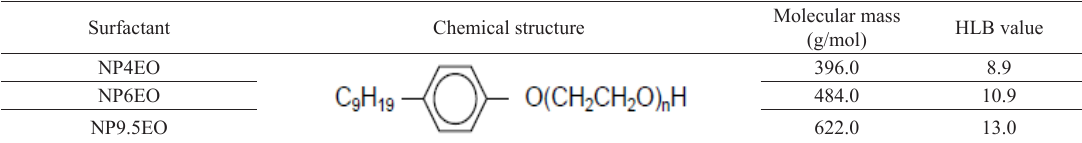
Table 1. Nonionic surfactants used and their properties 22 .